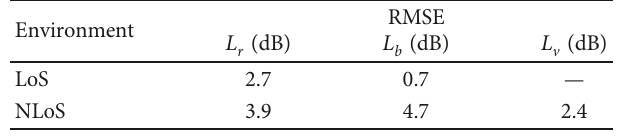
Figure 12: CDF on a route that passes over the house roof (at site- speci fi c). Table 4: Estimation errors of proposed model in suburban environments.